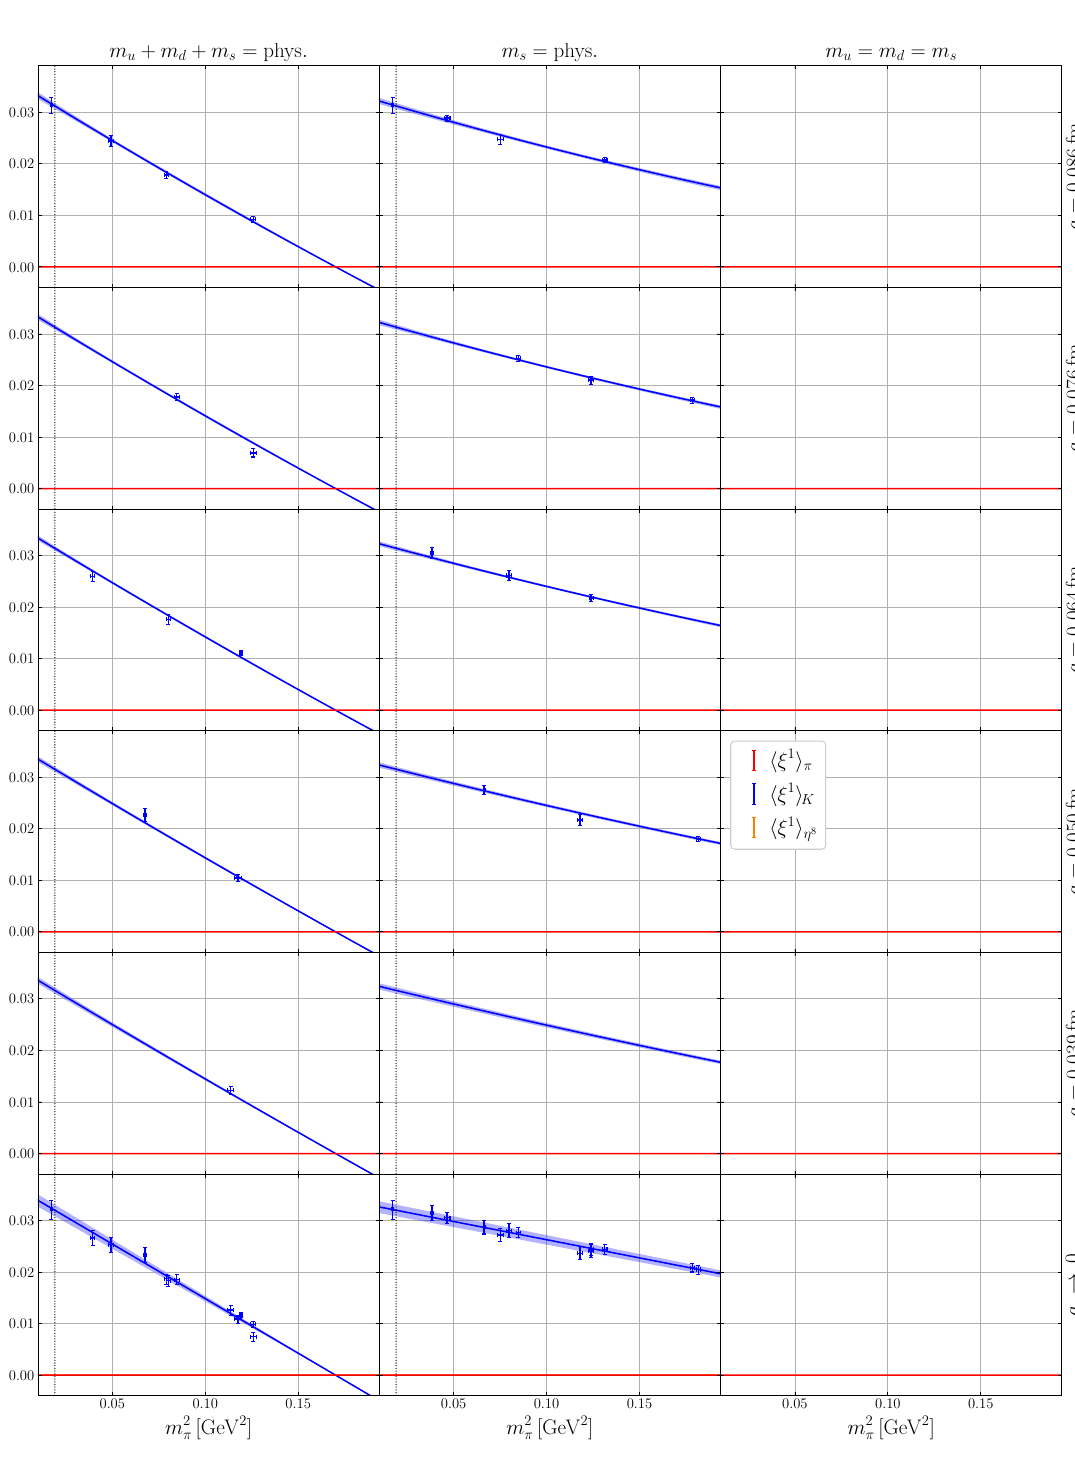
, defined in eq. (2.15a), plotted for ξ 1 (cid:31) (cid:30) M